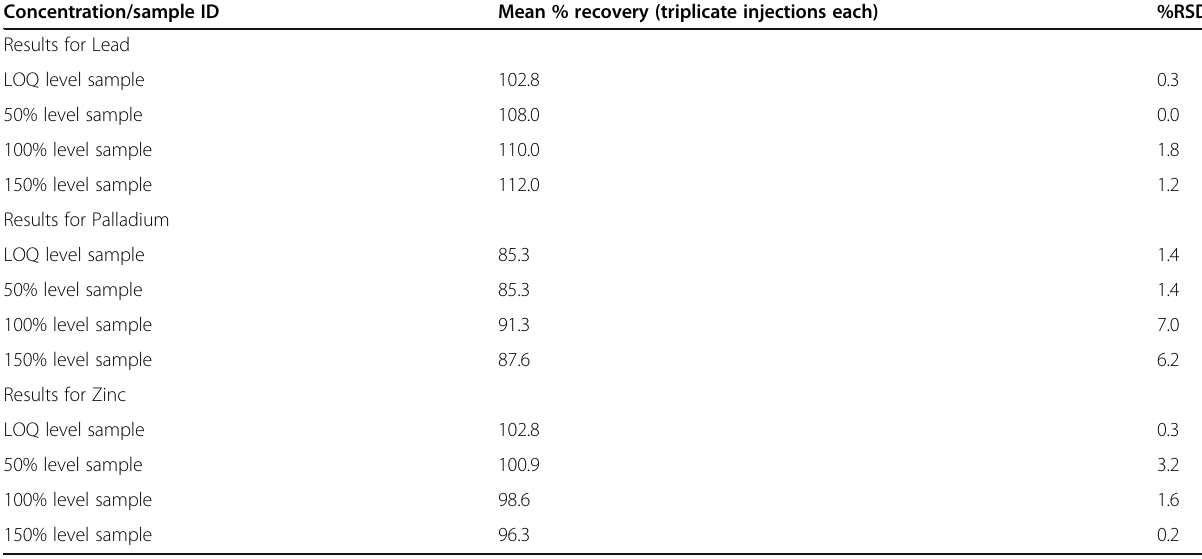
Table 8 Accuracy results for Lead, Palladium, and Zinc